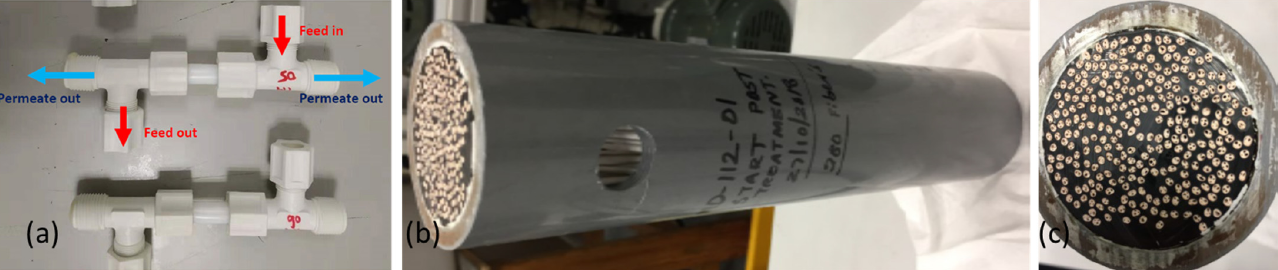
Figure 1. Scale up of tri-bore hollow fiber membrane modules. ( a ) Lab-scale testing modules (0.5-inch diameter), ( b , c ) pilot-scale modules (2-inch diameter).